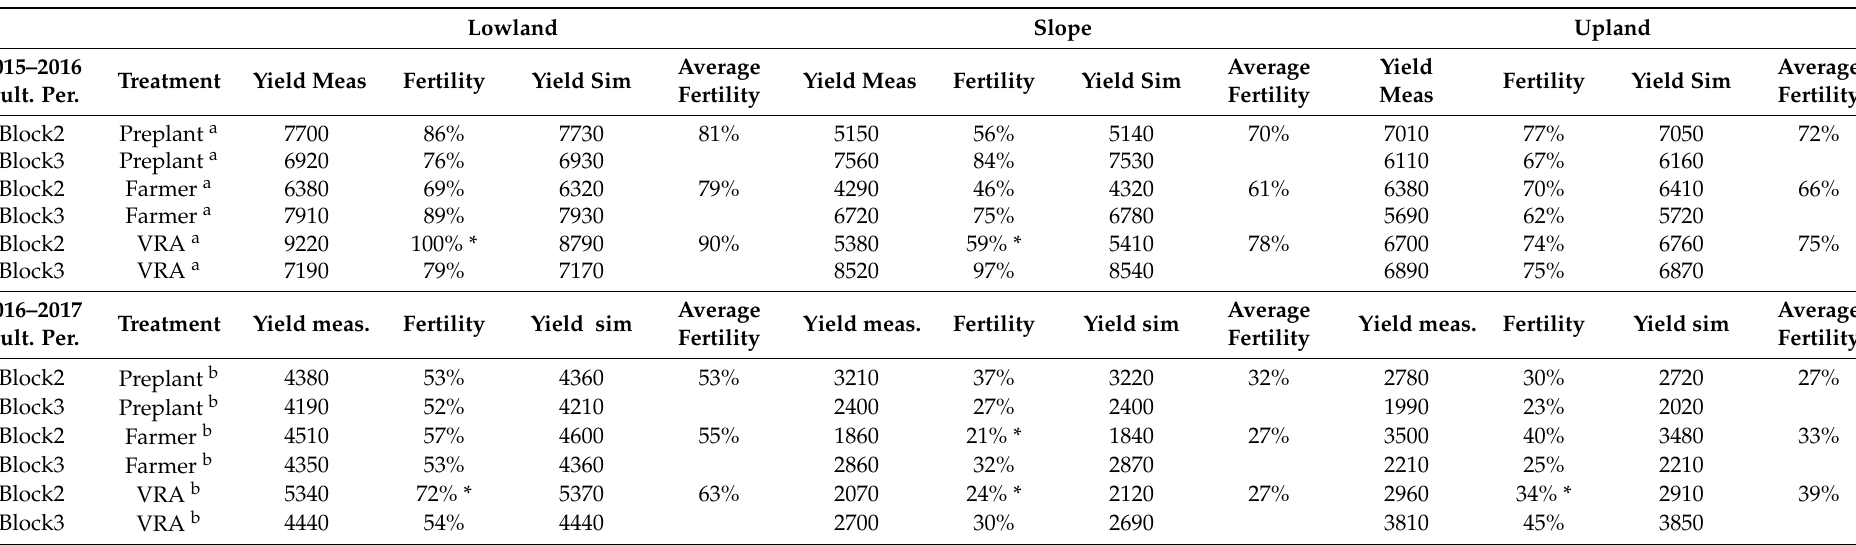
Table 6. Results of calibration simulations (kg/ha) using fertility as adjustment parameter. Average fertility for each zone treatment (Blocks 2 and 3). Lowland Slope Upland Average Fertility Yield Sim